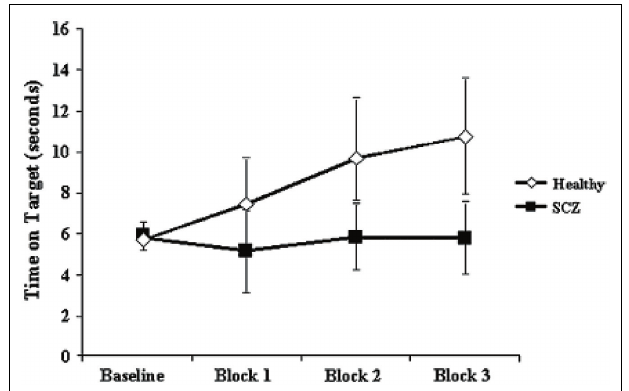
FIGURE 2 | Impaired motor skill learning in SCZ. Data represent mean ± standard deviation acquired for each of the three blocks of data acquired. Motor skill learning was derived through the rotary pursuit task. In this task, participants are required to hold a stylus upon a flat surface under which the target rotated and follow the target as it moved about its path. A photoelectric device measured the time (in seconds) that the stylus was held correctly over the target for each trial. Each block of skill learning consisted of eight 20-s trials with a 20-s intertrial interval.These data suggests that unlike healthy subjects, patients with SCZ failed to demonstrate significant motor learning (Frantseva etal., 2008).